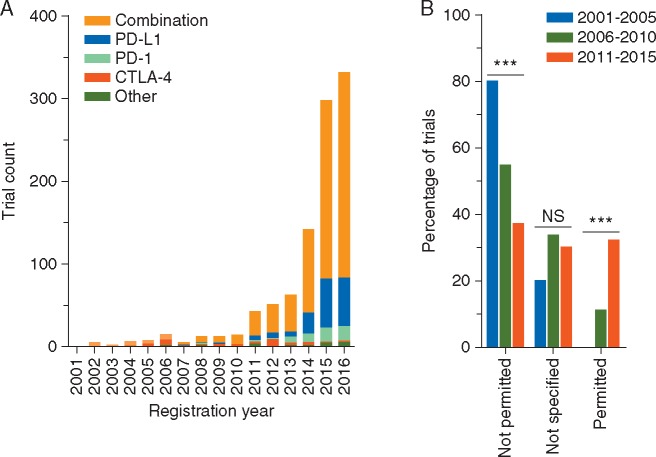
Longitudinal registration count and glucocorticoid administration in T cell checkpoint-targeted cancer immunotherapy trials. (A) Annual registration count of T cell checkpoint-targeted cancer immunotherapy trials. Trials registered by October 7, 2016 on the U.S. National Institutes of Health (NIH) trial registry were categorized according to year of registration and checkpoint protein target. T cell checkpoint proteins targeted in fewer than 10 trials are grouped as ‘other’, and include single agent OX40, GITR, CD137, B7-H3, LAG3, PD-L2, CD27 and trials comparing multiple checkpoint-targeting agents. ‘Combination’ trials include all pre-defined T cell checkpoint-targeted agents used in combination with another agent. (B) Specification of glucocorticoid administration within enrolment criteria of T cell checkpoint-targeted cancer immunotherapy trials. Trials registered on the U.S. NIH trial registry between 2001 and 2015 were categorized according to the specification of chronic systemic glucocorticoid administration within registered patient enrolment criteria. Univariate analysis for data presented was performed using the Cochran–Armitage test for trend assuming monotonical change over time and expected frequencies were met (80% of expected frequencies >5). ***P < 0.001; NS= not significant.